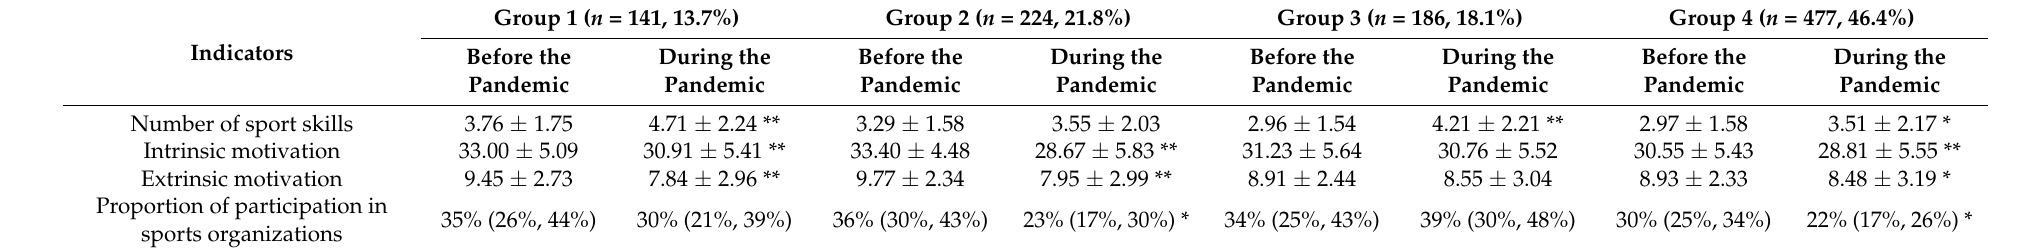
Table 5. Changes in skills, motivation and participation in sports organizations among the four groups before and during the pandemic.